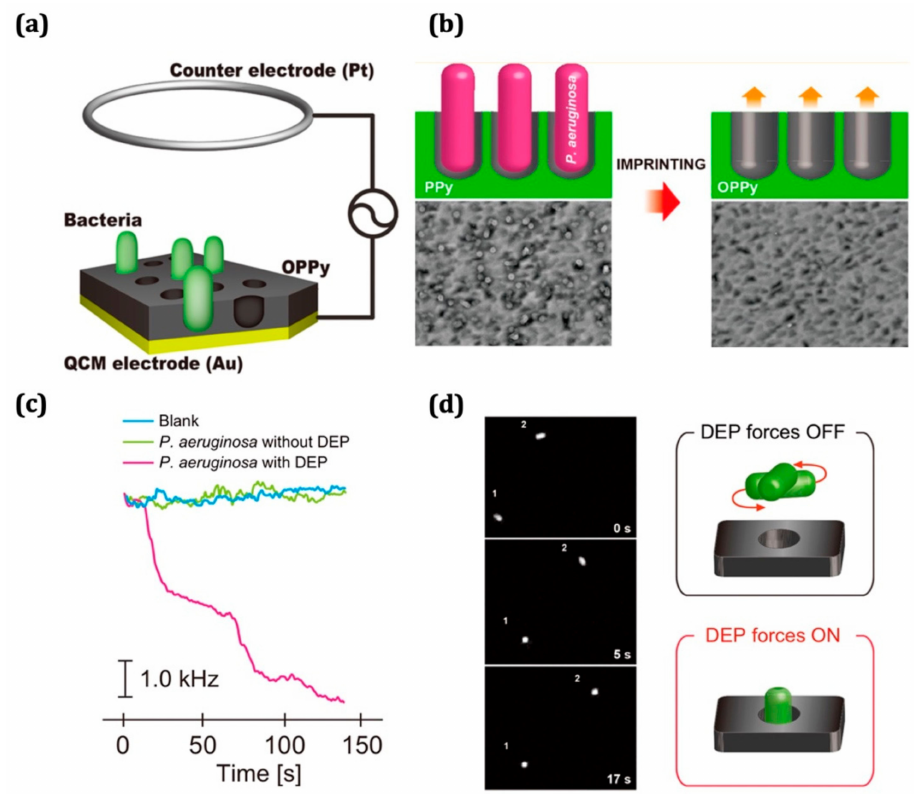
Figure 7. ( a ) QCM electrode; ( b ) SEM image of MIP thin film; ( c ) sensorgram of resonance frequency; ( d ) fluorescent microscope image of movement of P. aeruginosa . Reprinted with permission from ref. [161]. Copyright 2013 ACS